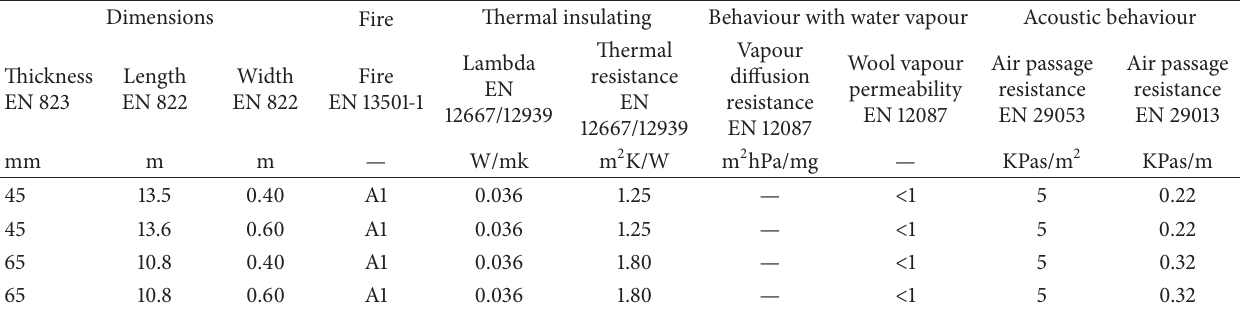
Table 5: Technical characteristics of the rock wool panel used in the research [15]. Dimensions Thermal